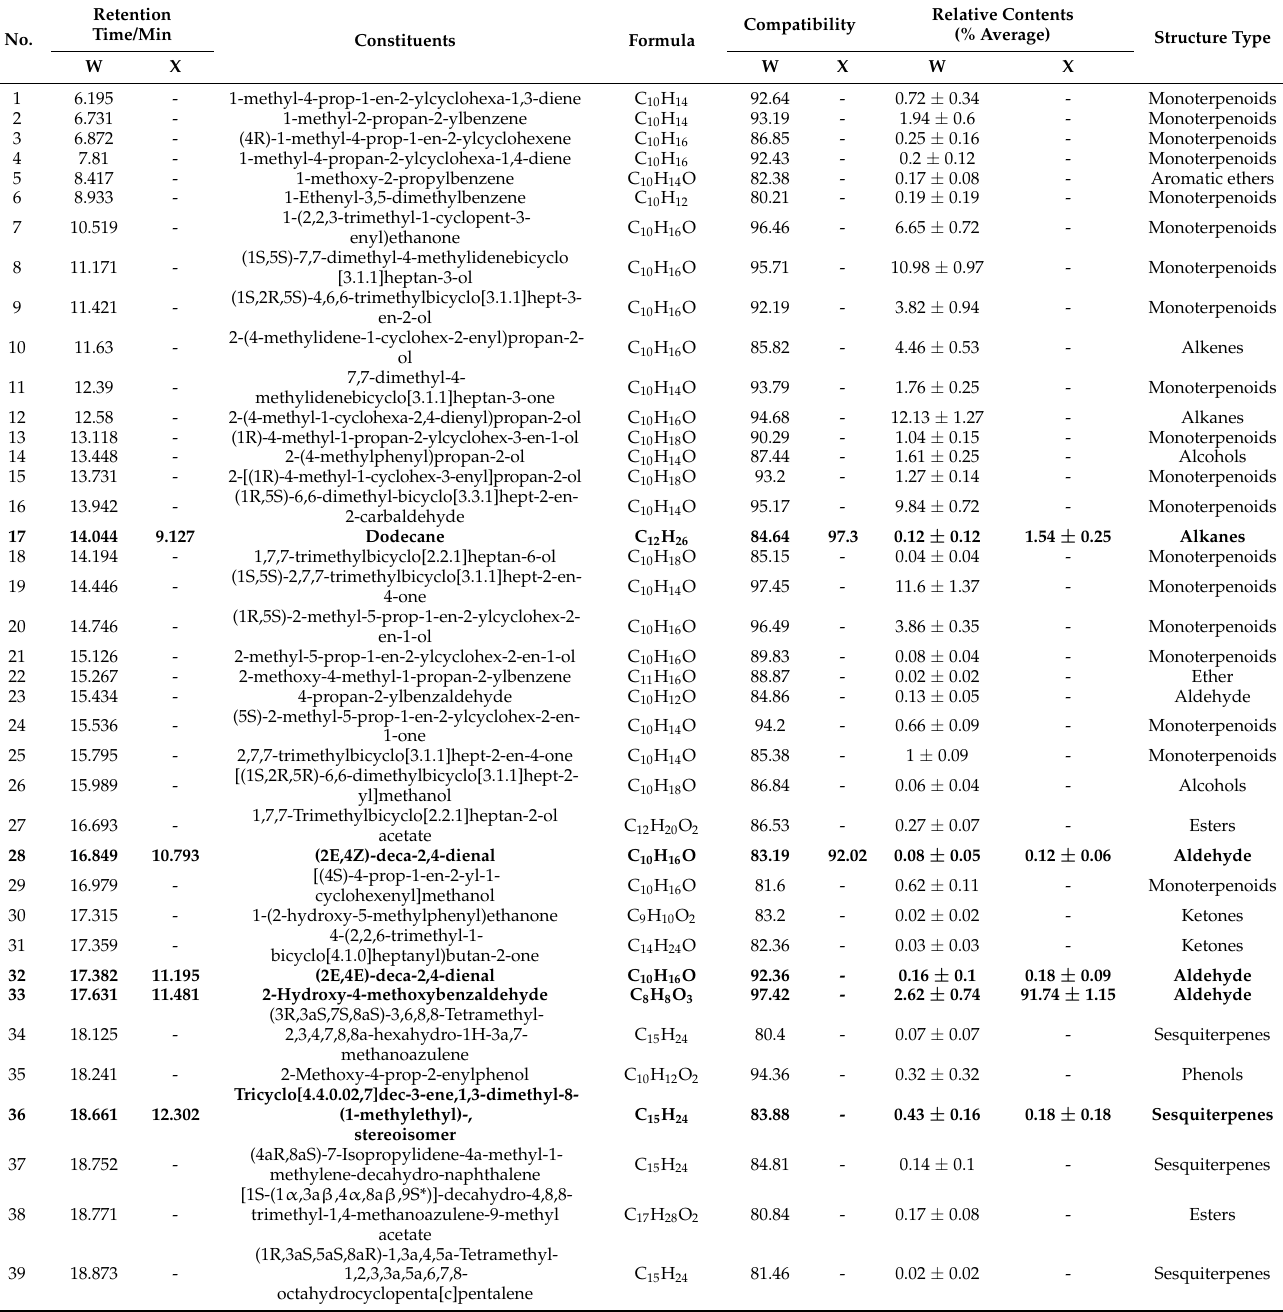
Table 1. The composition and relative contents of VOCs in Acanthopanacis Cortex and Periplocae Cortex ( n =